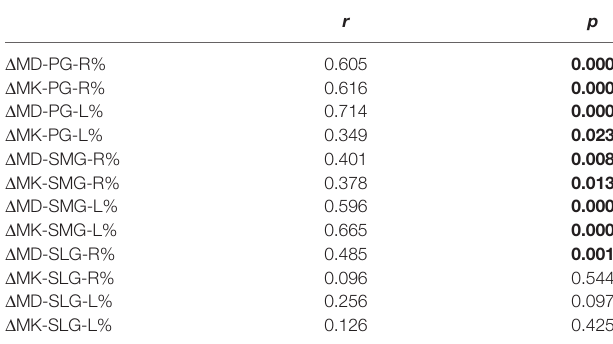
r represents correlation coef fi cients. The correlation analysis was conducted between the change ratio ofthe DKIparameters (MDand MK) frompre-RT topost-RT with thedose of ipsilateral salivary glands. The bold values represent p<0.05. Abbreviations are referred to in Table 2